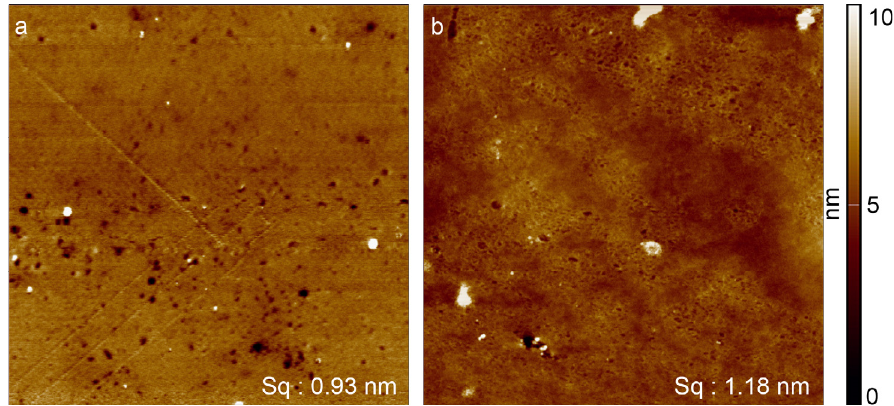
Figure 2. AFM images of PS before and after atmospheric plasma jet treatment. The images have an edge length of 10 µm. ( a ) Unmodi fi ed PS surface with a roughness of 0.93 nm (S q ). ( b ) PS surface after exposure to a plasma containing acrylic acid at atmospheric pressure, with a roughness of 1.18 nm (S q ).